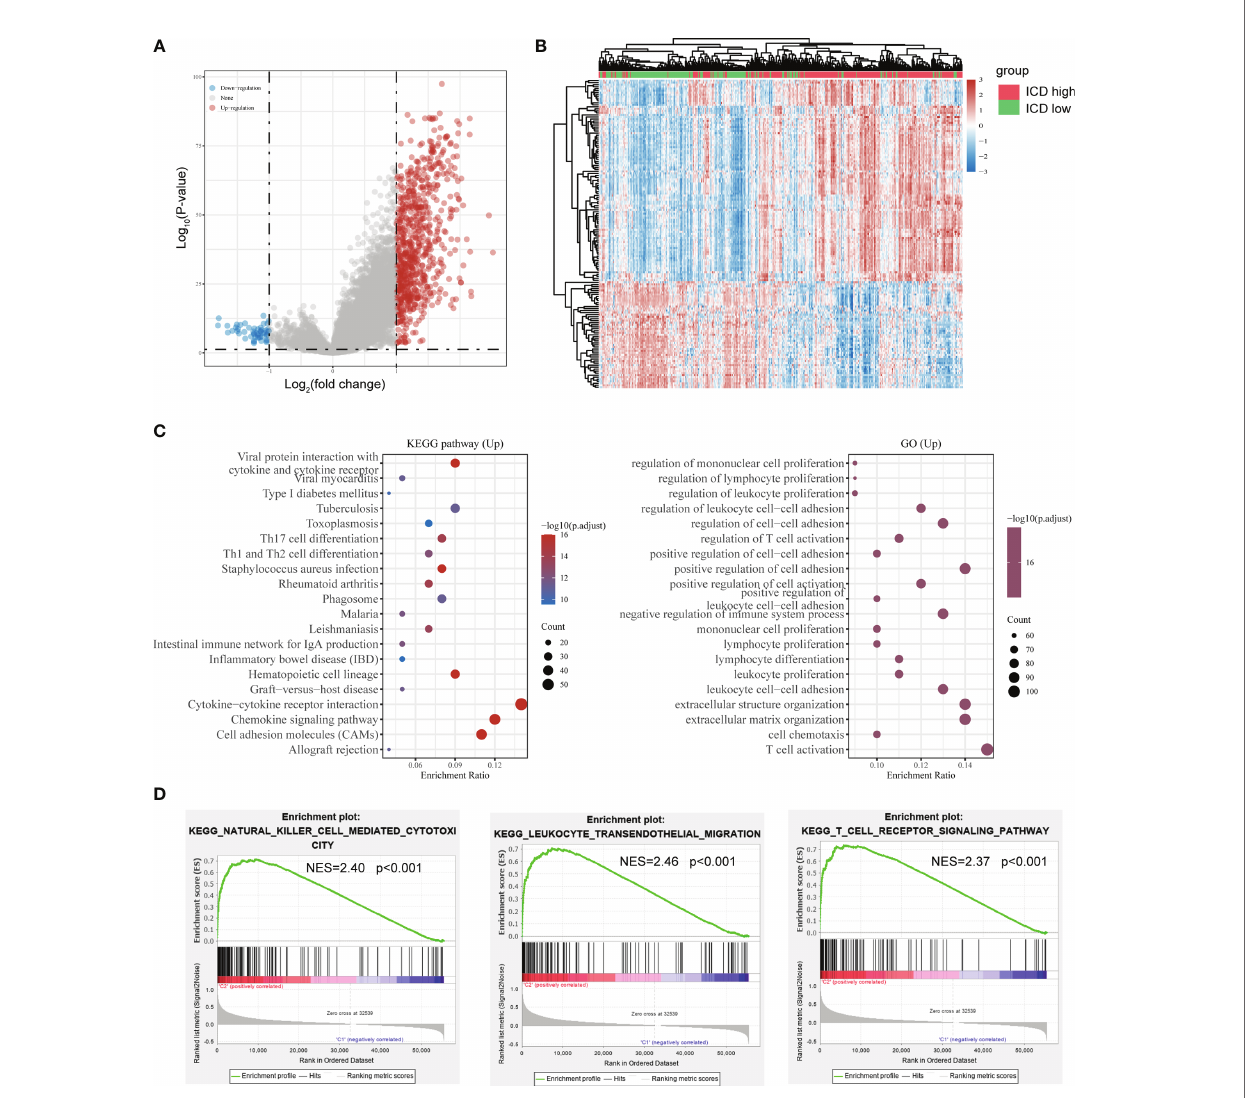
FIGURE 2 | Identi fi cation of differentially expressed genes (DEGs) and underlying signal pathways in different subtypes. (A) Volcano plot presents the distribution of DEGs quanti fi ed between ICD-high and ICD-low subtypes with threshold of |log2 Fold change| > 1 and P < 0.05 in TCGA cohort; (B) Heatmap shows the DEG expression in different subtypes; (C) Dots plot presents the KEGG and GO signaling pathway enrichment analysis. The size of the dot represents gene count, and the color of the dot represents – log 10 (p. adjust-value); (D) GSEA analysis determines the underlying signal pathway between ICD-high and ICD-low